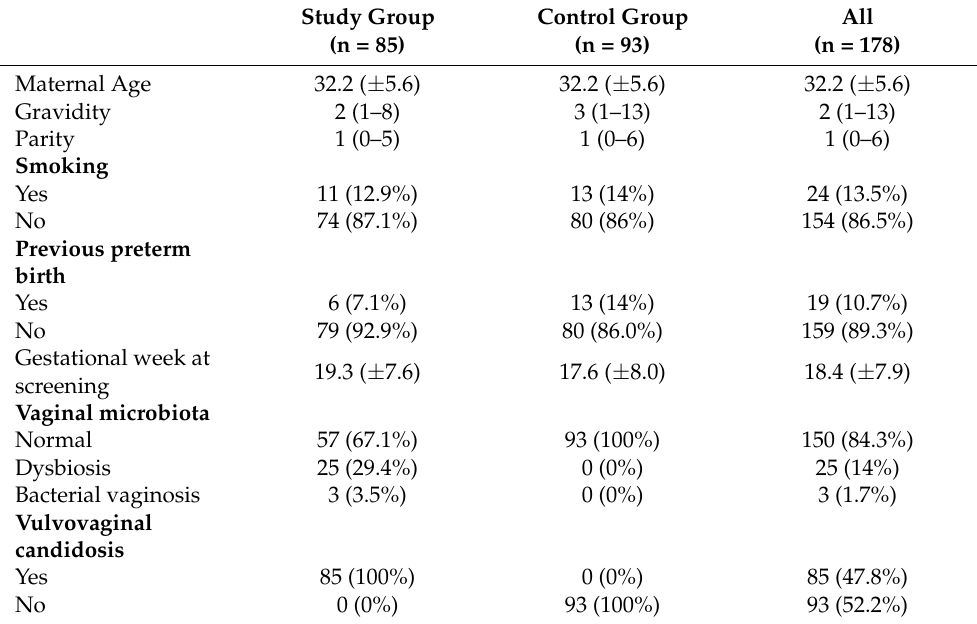
Table 1. Characteristics of 178 asymptomatic pregnant women who were screened for VVC using. Gram-stained smears and the SavvyCheck ™ Vaginal Yeast Test .